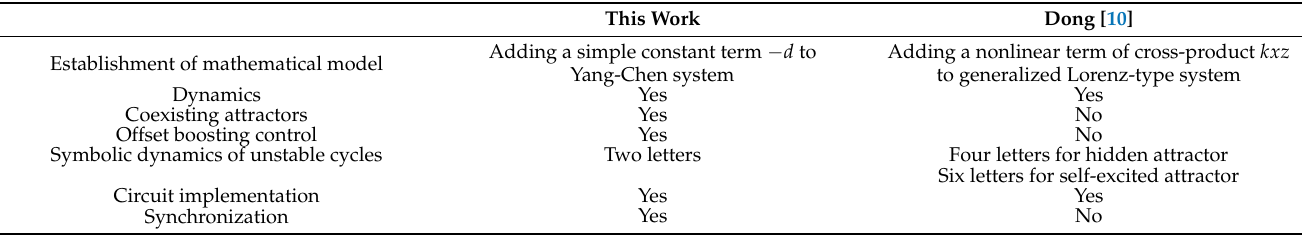
Table 2. Analysis methods used in investigating the two chaotic